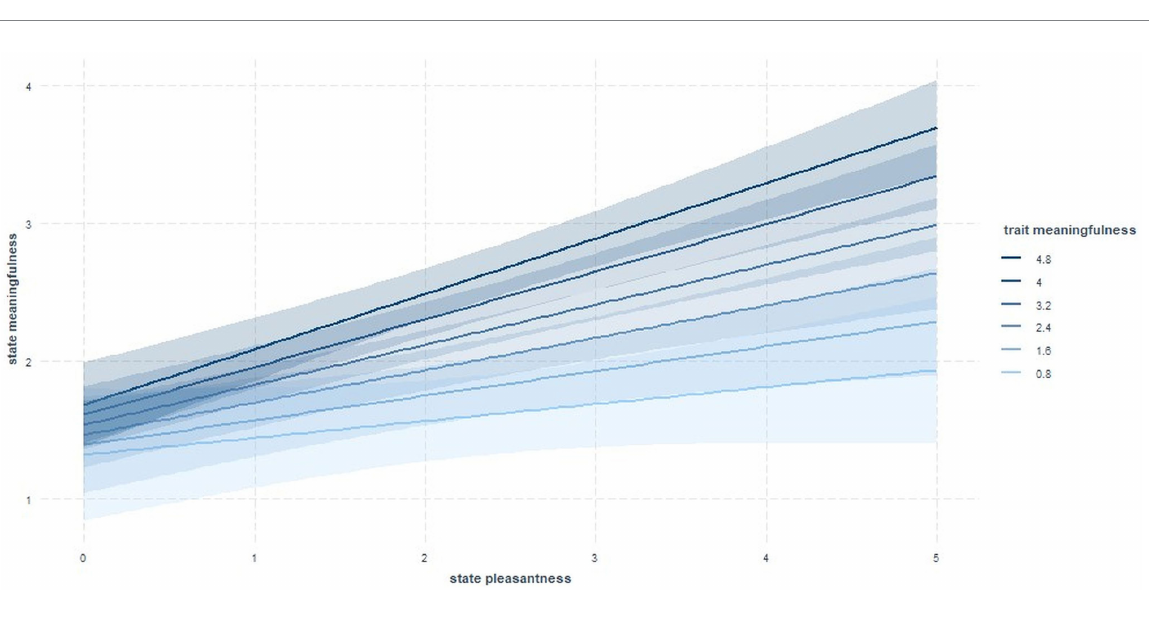
FIGURE 1 Interaction of trait meaningfulness and state pleasantness in the prediction of state